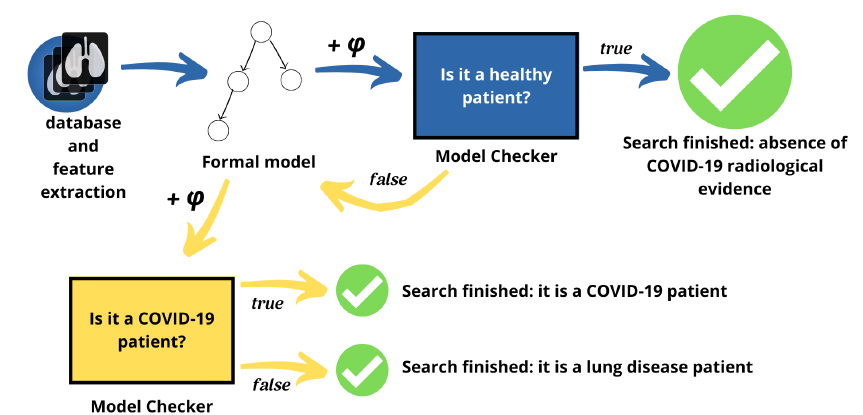
Figure 3. A description of the two-tier method: blue represents the classification of healthy and lung sick patients; yellow represents the classification of lung disease patients and COVID-19